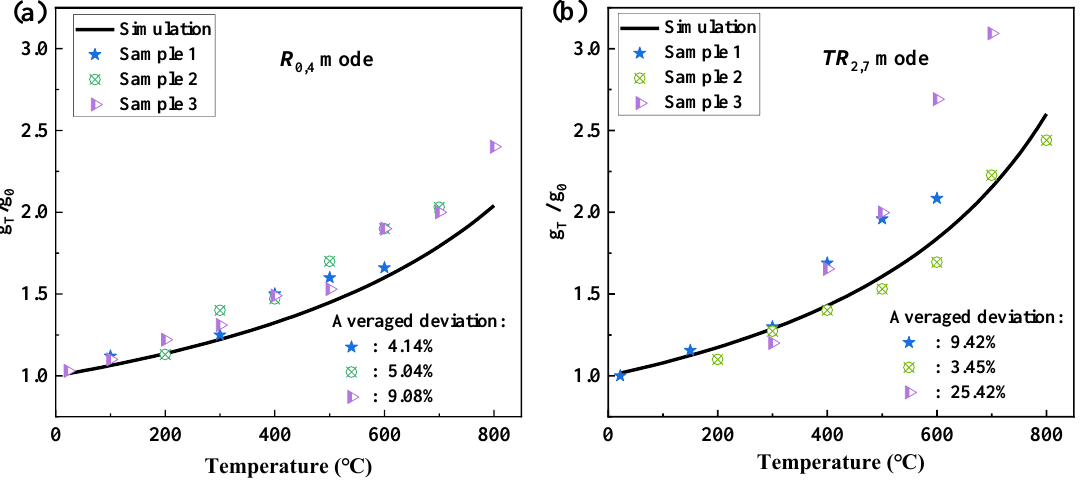
Figure 6. Measured and calculated g T /g 0 of ( a ) R 0,4 mode, and ( b ) TR 2,7 mode induced GAWBS at different temperatures.